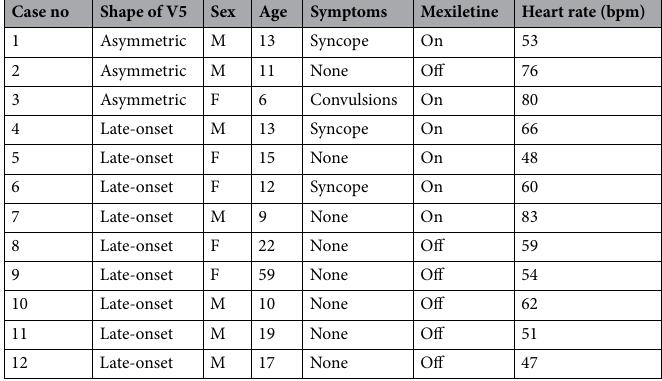
Table 1. Clinical characteristics of patients with LQTS3 (E1784k gene